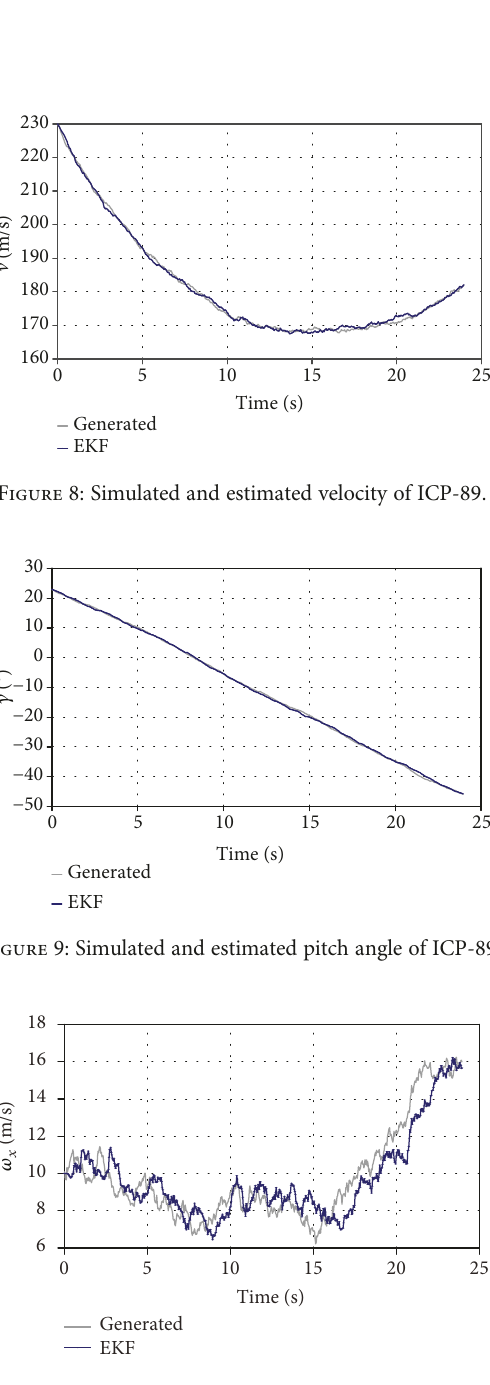
Figure 10: Simulated and estimated horizontal component of